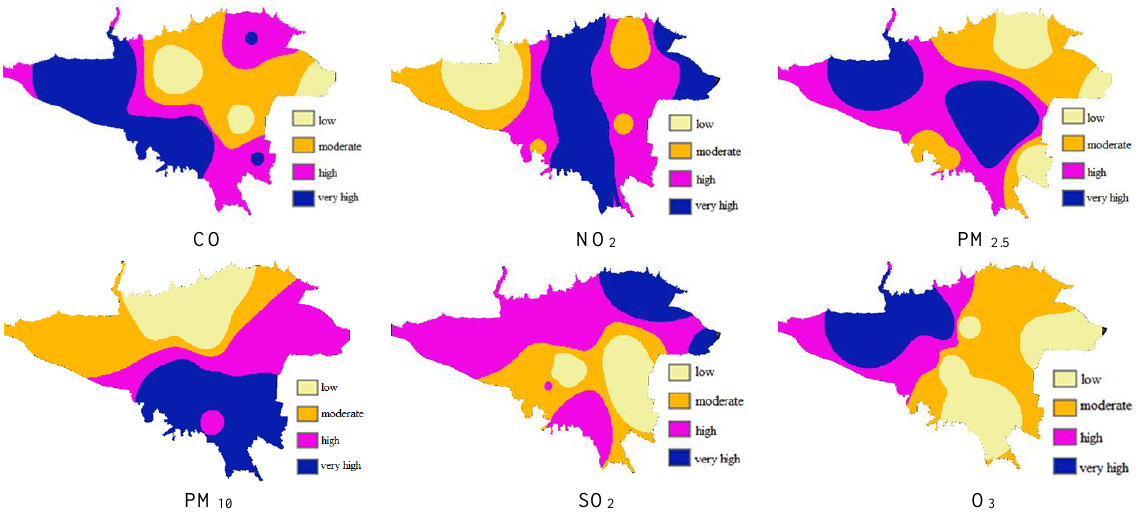
Figure 4. The categorized maps of different air pollutants in Tehran in December